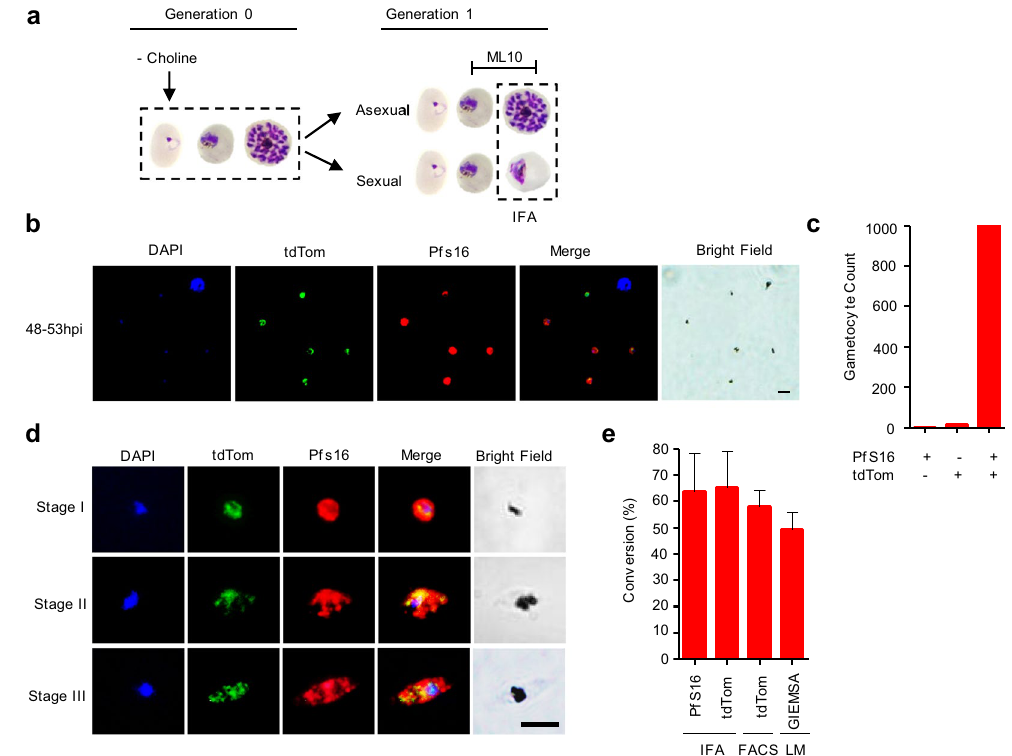
Figure 2. Expression of gexp02-Tom in sexual stage parasites. ( a) Schematic overview of the experiment design with tightly synchronized NF54-gexp02-Tom cultures. Sexual conversion was induced by choline-depletion at the ring stage. ML10 was added at ~30–35 h post-invasion (hpi) of the next cycle to prevent schizont rupture. (b) Representative immunofluorescence assay (IFA) image of NF54-gexp02-Tom cultures at ~48–53 hpi. Mononucleated parasites (stage I gametocytes) express tdTom and Pfs16. Scale bar: 5 µ m. (c) Distribution of parasites positive for the different markers by IFA (1,176 single-nucleated parasites scored). (d) Representative IFA images of gametocytes (stages I-III) showing expression of tdTom and Pfs16 in the same parasites. Scale bar: 5 µ m. (e) Sexual conversion rates of the NF54-gexp02-Tom line as determined by IFA, flow cytometry (FACS) (gametocytemia determined at ~48–53 hpi), and Giemsa-stained blood smears (gametocytemia determined on day 4). Data are presented as the average and s.e.m. of three independent biological